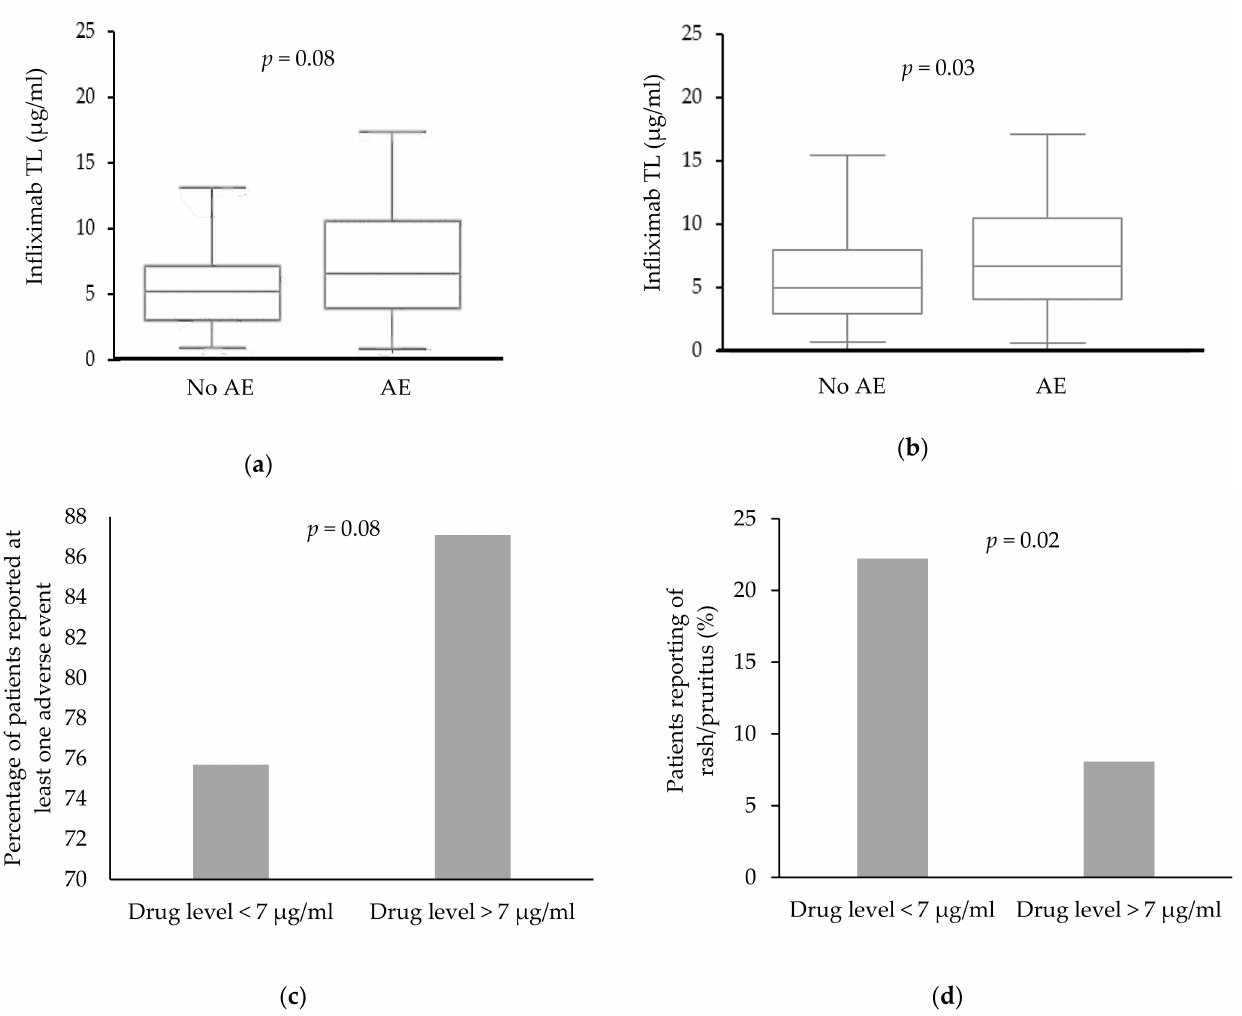
Figure 1. Association between infliximab serum drug levels and the reporting of adverse events (AEs). ( a ) Association between infliximab levels and reporting of at least one AE. ( b ) Association between infliximab levels and reporting of at least one AE, excluding fatigue and abdominal pain. ( c ) Association between infliximab trough levels of below or above 7 µ g/mL and reporting of at least one AE. ( d ) Percentage of patients reporting of a new rash or pruritus among patients with infliximab trough drug levels below or above 7 µ g/mL. Abbreviations: AE = adverse event; and TL = trough